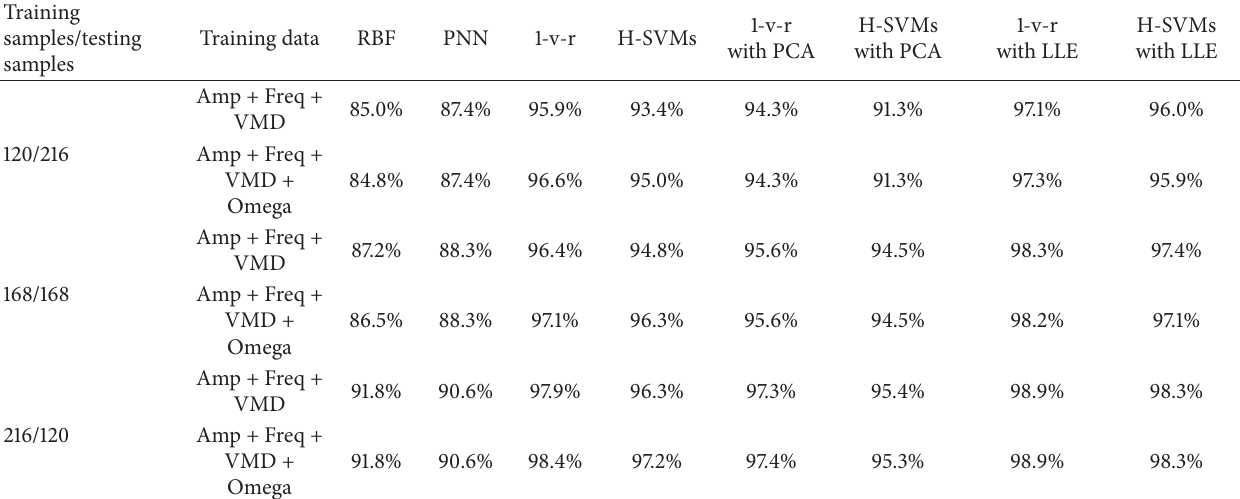
Table 6: Classification results with different selected numbers of training